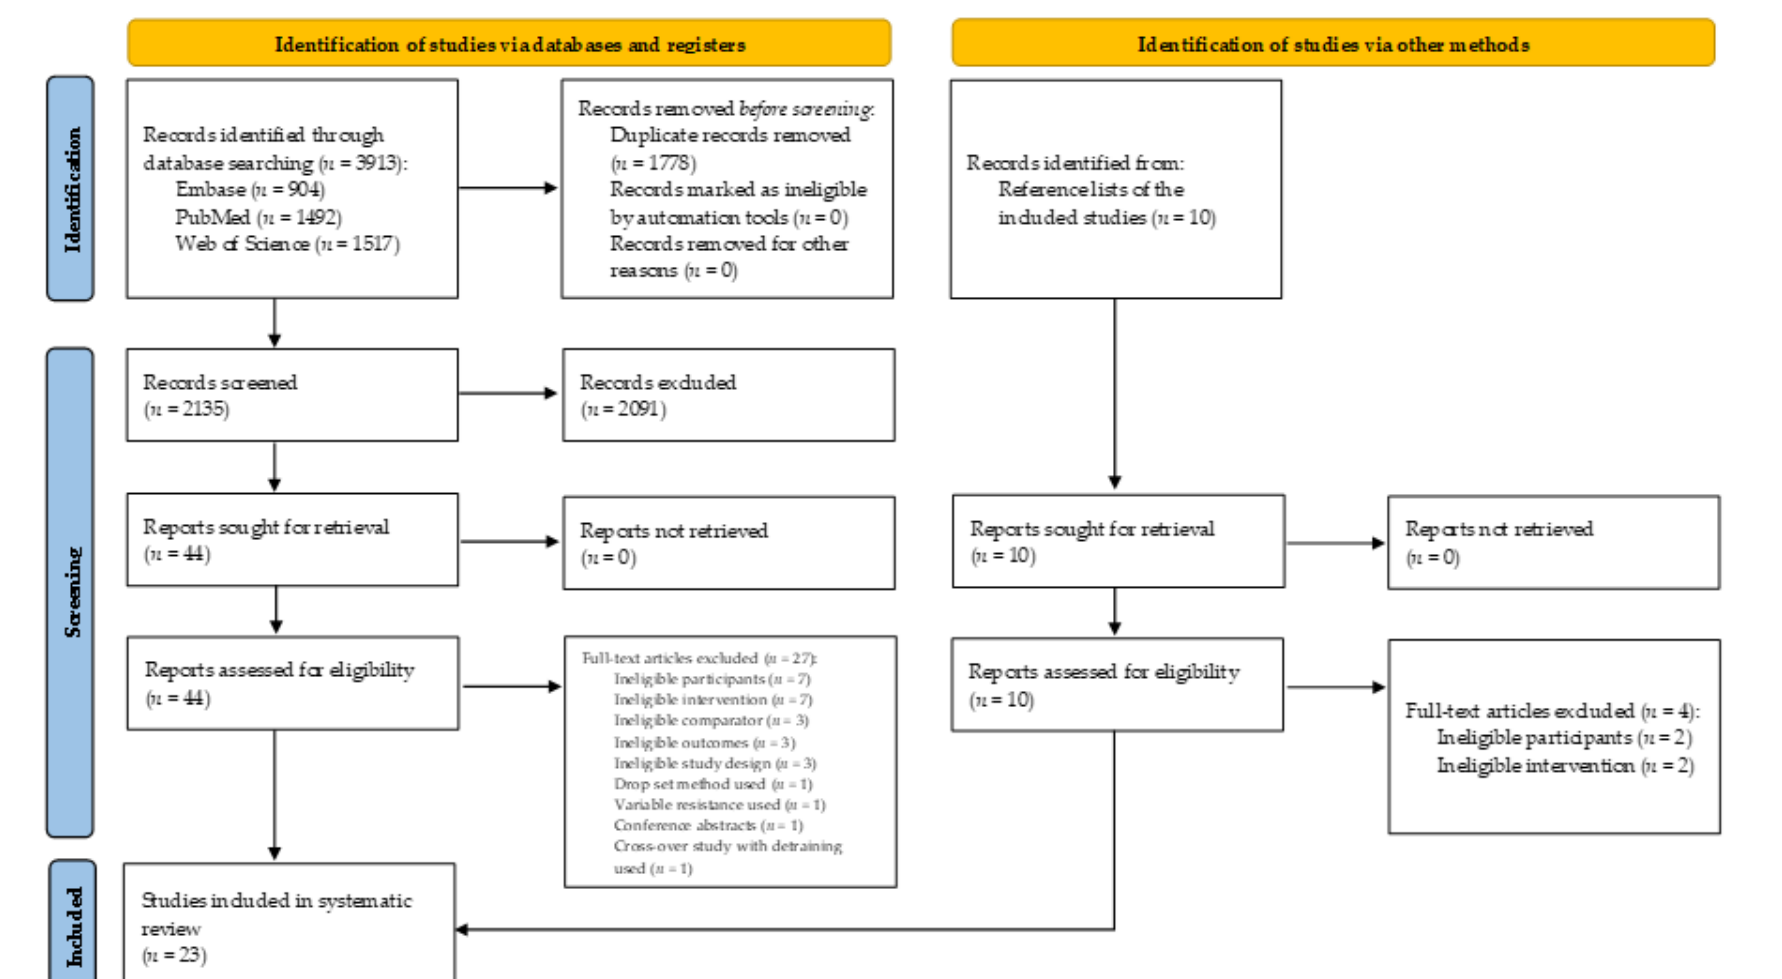
Figure 1. PRISMA 2020 flow diagram for this systematic review, which included searches of databases, registers, and other